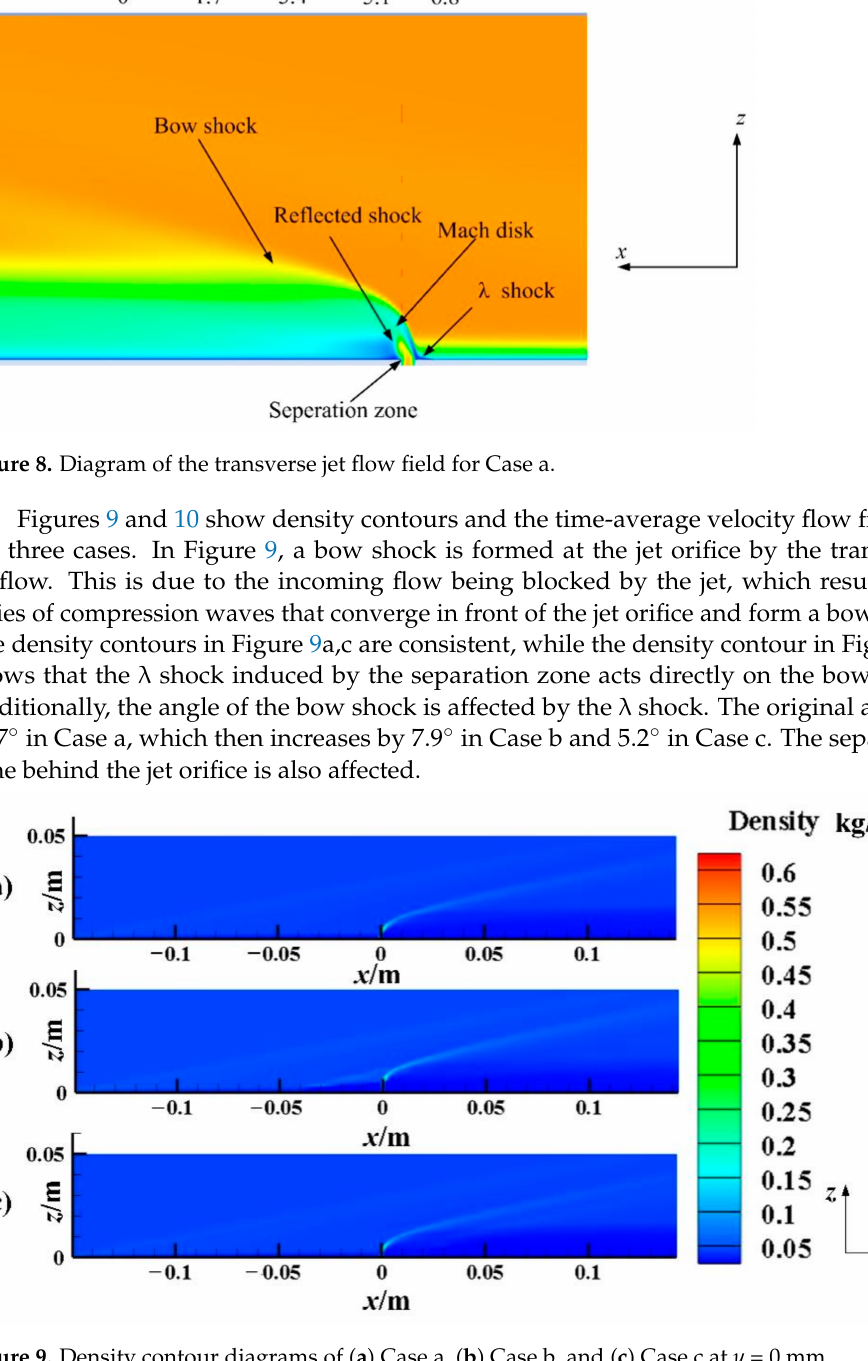
Figure 9. Density contour diagrams of ( a ) Case a, ( b ) Case b, and ( c ) Case c at y = 0